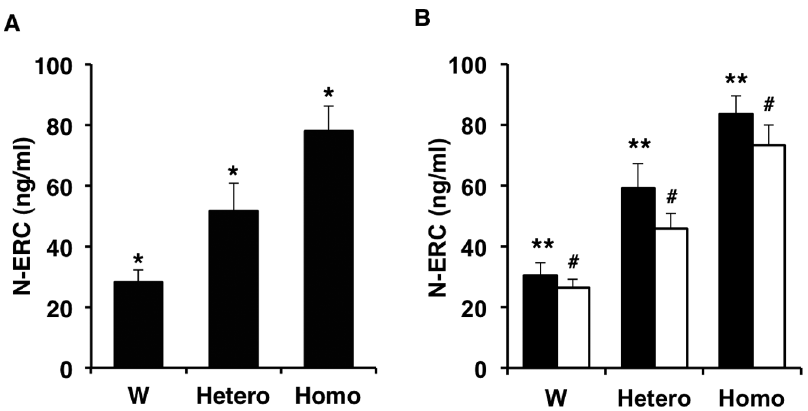
Figure 1. Comparison of serum levels of N-ERC/mesothelin in wild type Jcl:SD (W) and heterozygous (Hetero) and homozygous (Homo) Kras301 rats. Heterozygous Kras301 rats were generated by breeding homozygous Kras301 rats with wild type Jcl:SD rats. (A) Serum levels of N-ERC/mesothelin in wild type Jcl:SD rats and heterozygous and homozygous Kras301 rats. (B) Serum levels of N-ERC/mesothelin in male (closed bar) and female (open bar) wild type Jcl:SD rats and heterozygous and homozygous Kras301 rats. *, ** and # , P , 0.0001 compared with each other.